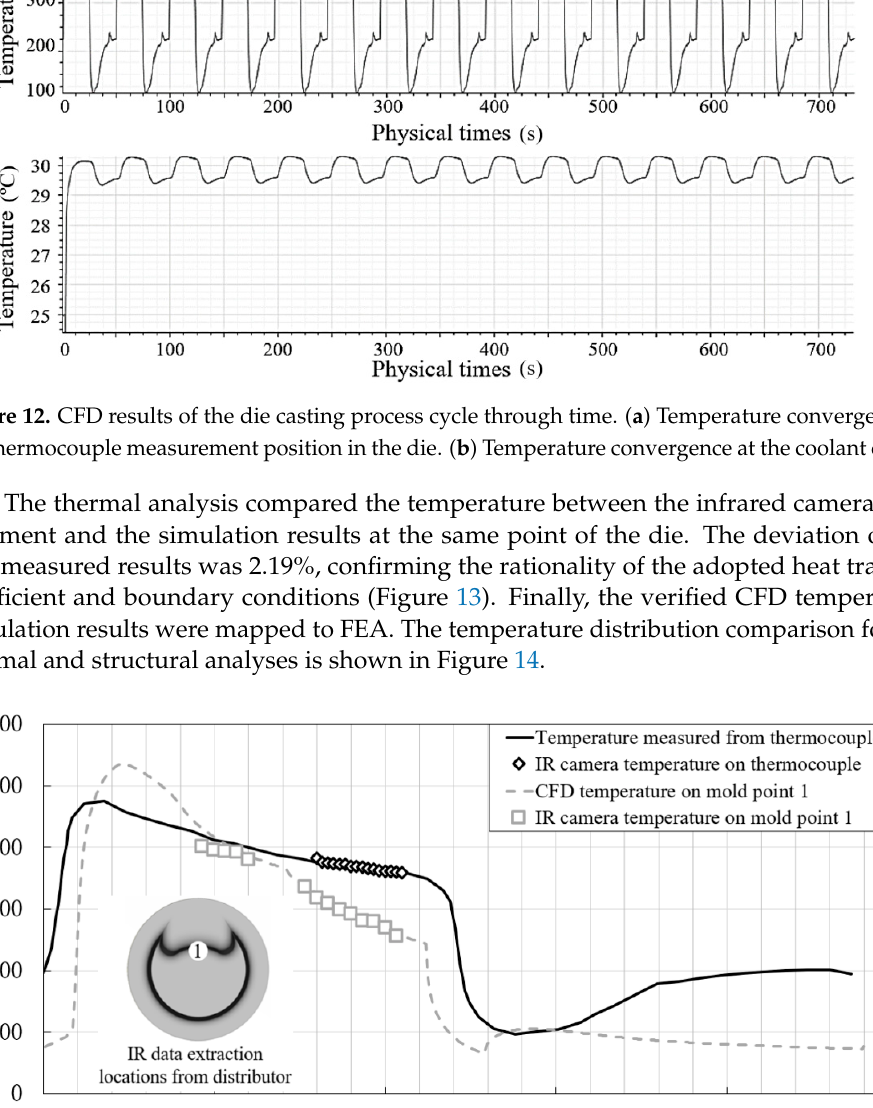
Figure 14. Temperature distribution of thermofluid analysis and IDW interpolation. ( a ) Tempera- ture from the top view of the entire analysis model ( left : CFD, right : FEA). ( b ) Temperature from an isometric perspective of the distributor ( top : CFD, bottom : FEA). The thermal strain and stress have been calculated by the FEA model based on the mapped CFD temperature results. The maximum thermal stress applied to the die was 1003.7 MPa. The structural analysis model was verified by observing the fracture location of the distributor, which showed the fastest breakage in the die. The location of crack ini- tiation and the length of the fracture were measured. The highest thermal stress position and the area with the most notable change in thermal stress were identical to the fracture location of the distributor. In conclusion, it was confirmed that the actual thermal stress- induced failure could be predicted through the one-way coupled thermo-structural anal- ysis. Figure 15 shows the die’s thermal strain–stress distribution and crack locations.